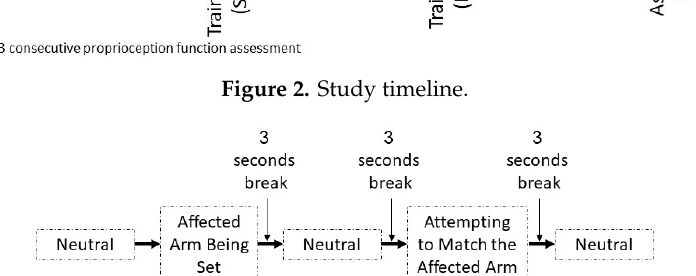
Figure 3. Steps in assessment of ipsilateral movements.